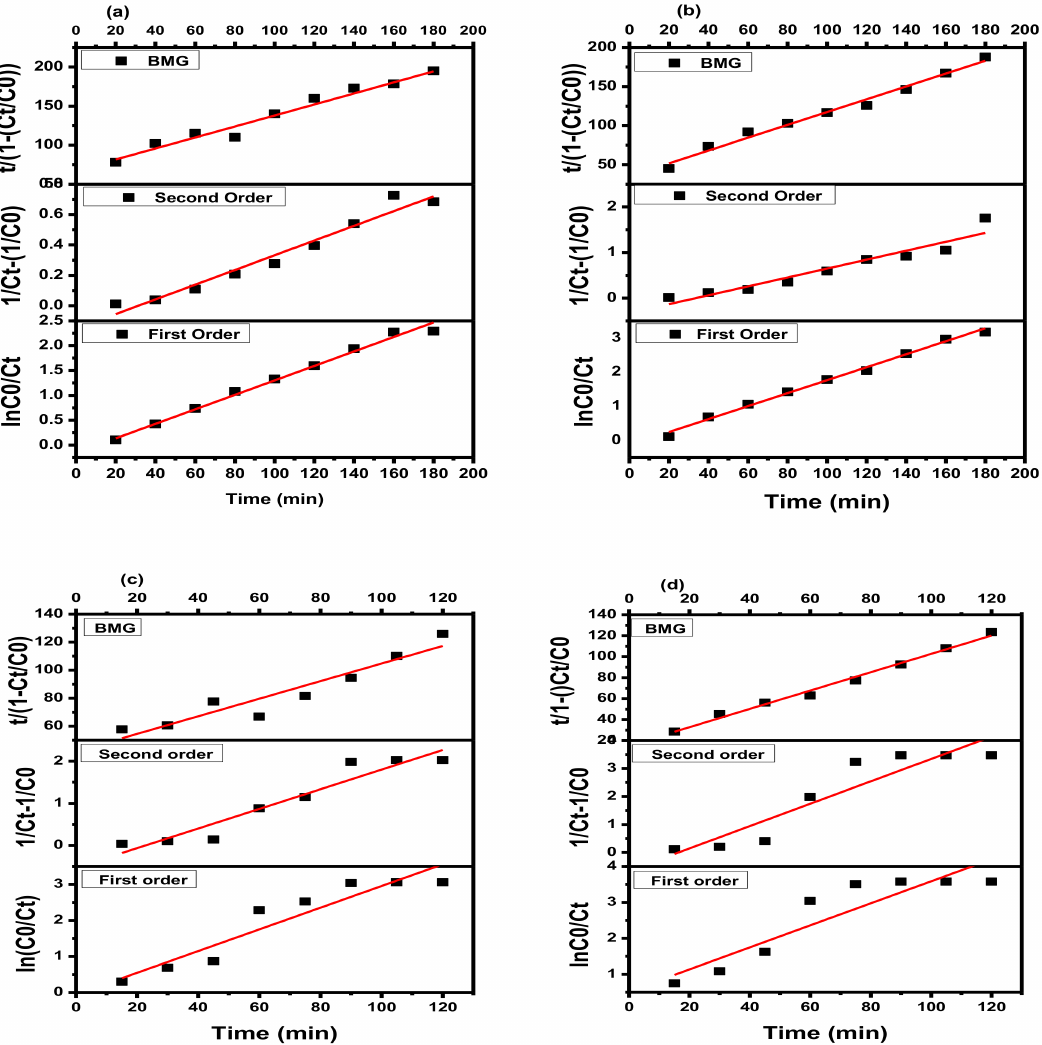
Figure 5. Kinetic model for the degradation of acetamiprid using ( a ) Fe 3 O 4 and ( b ) GO-Fe 3 O 4 , ( c ) CoFe 2 O 4 and ( d ) GO-CoFe 2 O 4 . Table 2. Values of the coefficient of correlation and rate constant of acetamiprid degradation using different catalysts.